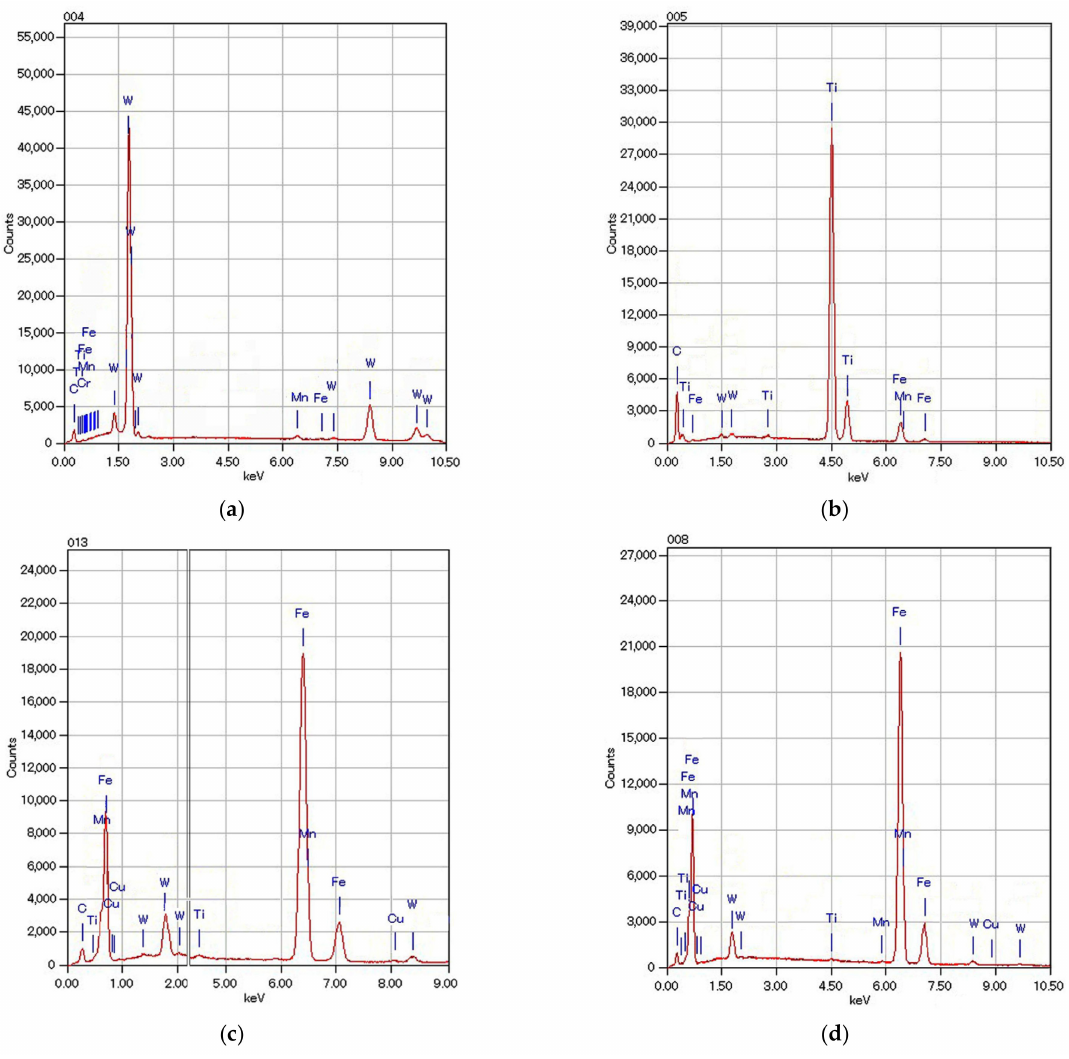
Figure 10. EDX-spectra for the indicative points shown in Figure 8: ( a ) WC carbide (point 004), ( b ) TiC carbide (point 005), ( c ) “carbide network”-matrix (point 013), ( d ) carbide-free matrix (point